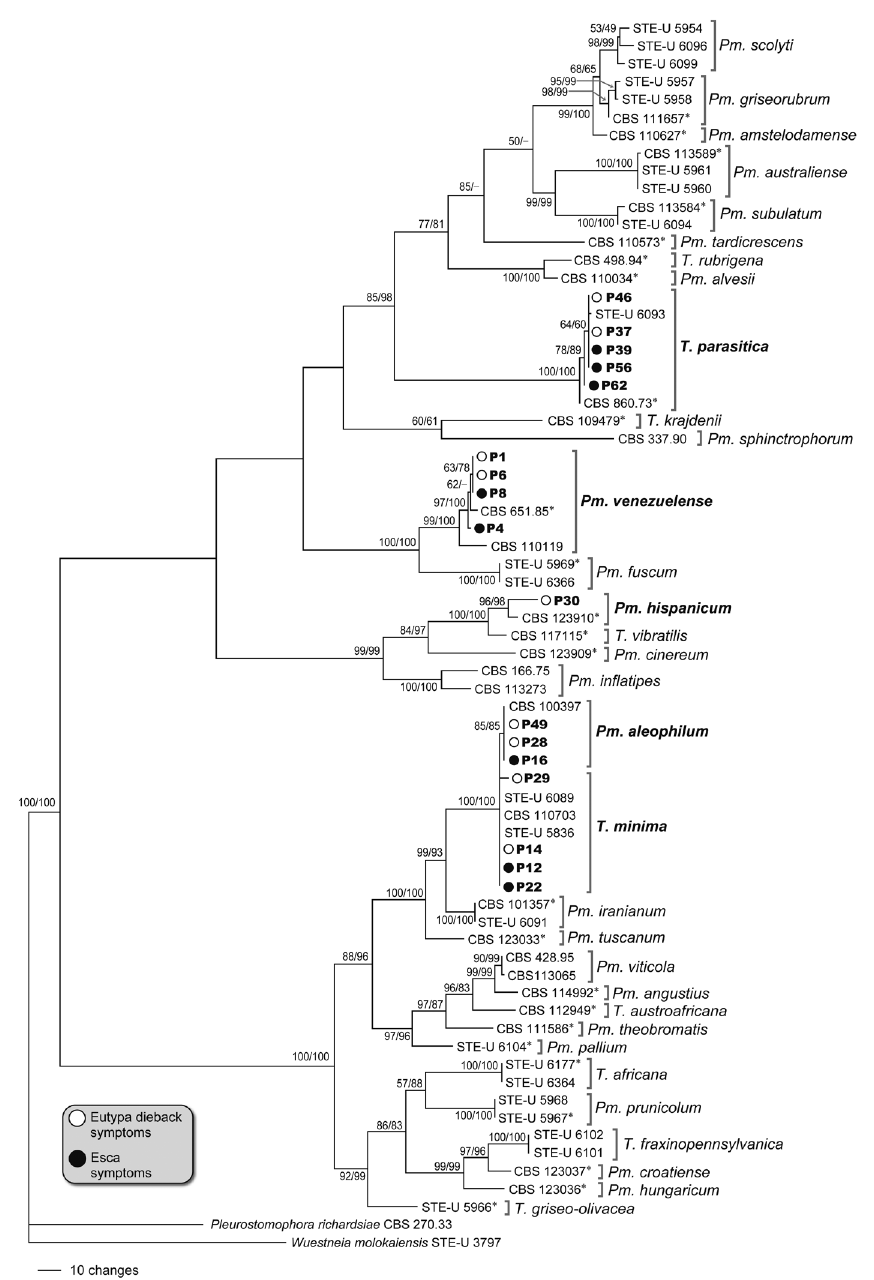
Figure 2. One of 4 equally parsimonious trees resulting from the alignment of 854 characters of combined TUB and ACT partial sequences. Length = 1614; consistency index (CI) = 0.511; retention index (RI) = 0.857; homoplasy index (HI) = 0.489. Newly generated sequences are highlighted in boldface and listed by their isolate number. Ex-type cultures are marked with an asterisk. Isolates obtained in this study from vines with eutypa dieback or esca are marked with white and black circles respectively. Bootstrap values from 1000 replications are shown for Maximum Parsimony (MP) and Neighbour-Joining (NJ) at the tree nodes (MP/NJ). Branches marked with a minus (–) are not present in the NJ tree. Pleurostomophora richardsiae (Genbank ACT: AY579271; TUB: AY579334) and Wuestneia molokaiensis (Genbank ACT: AY579335; TUB: AY579272) were included as